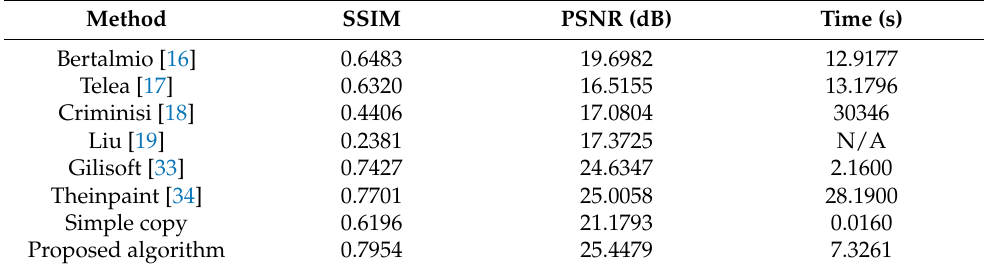
Table 1. Comparison between performances of various methods for outdoor pictures (Mozart Hall).